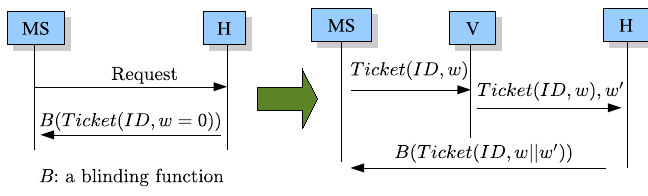
Figure 2. Overview of the proposed